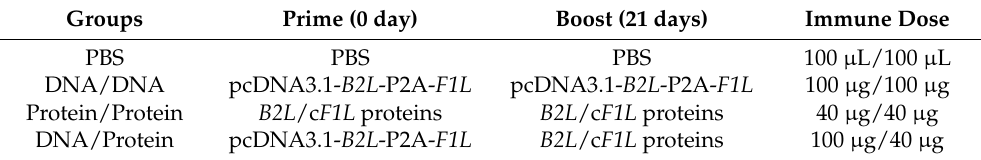
Table 2. Inoculation details of